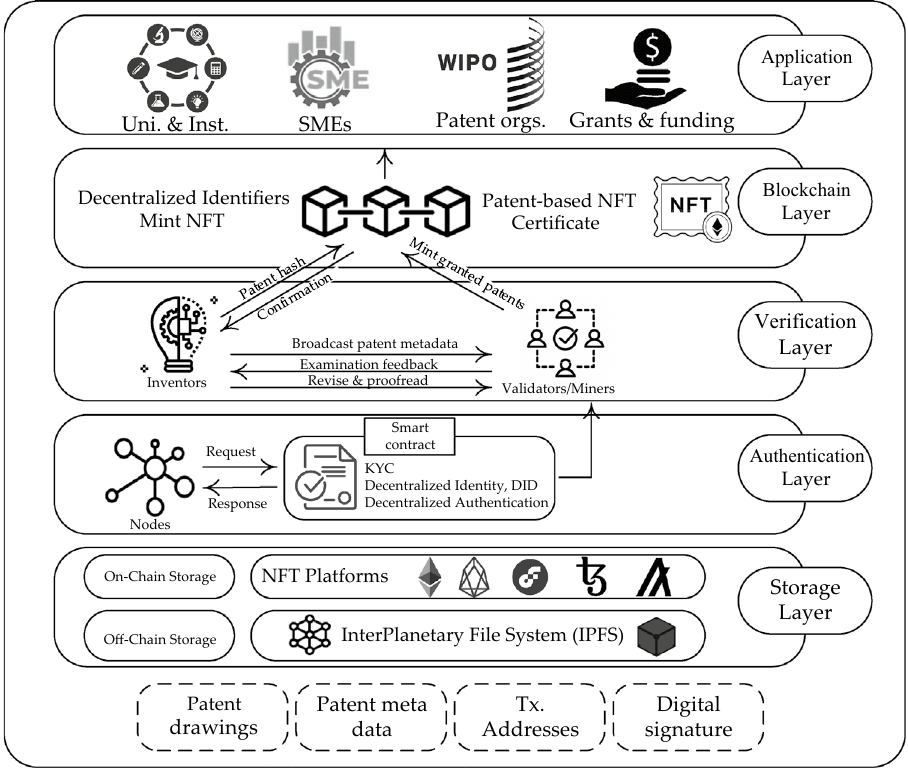
Figure 2. Proposed Architecture for Presenting NFT-based